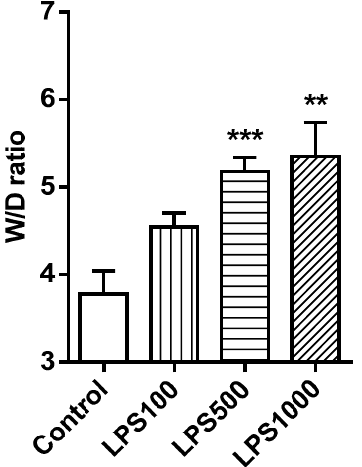
Figure 1. Lung edema formation at the end of the experiment. Values represent the W/D (wet/dry) weight ratio of lung tissue. Control vs. LPS-treated groups ** p < 0.01, *** p < 0.001.